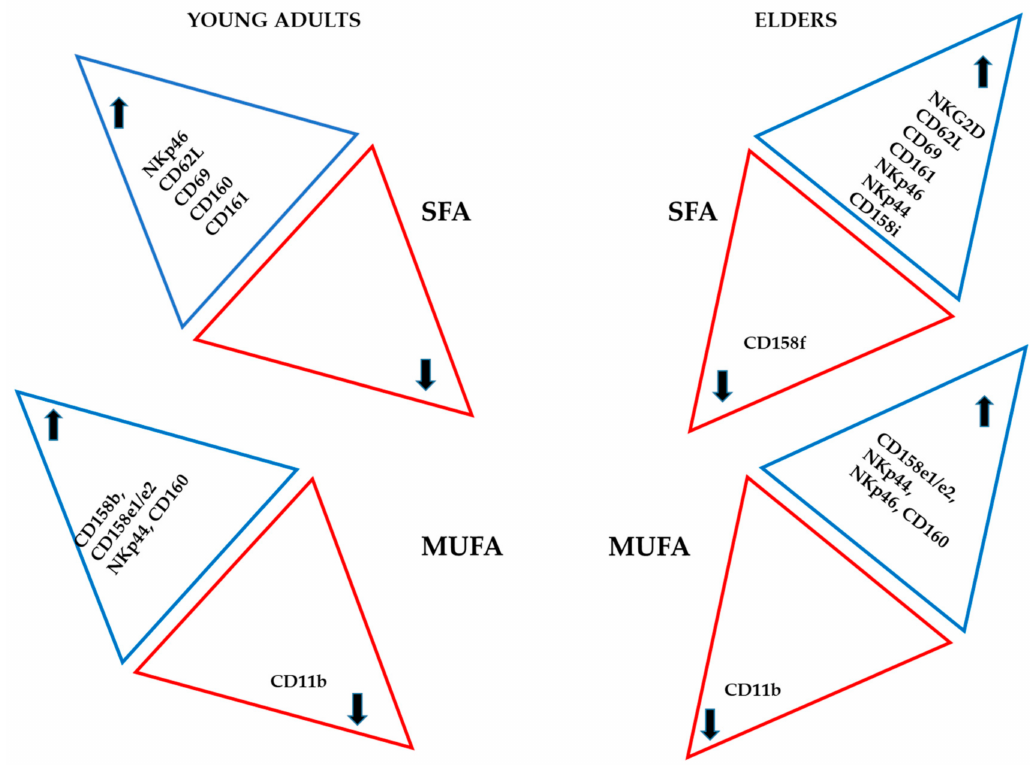
Figure 5. E ff ect of saturated (SFA) and w9 monosaturated fatty acids (MUFA) on the expression of di ff erent antigens in NK cells from healthy young adults and healthy elder subjects. The arrows indicate an increase or decrease of the antigens. SA corresponds to saturated fatty acids, w9 to OA and